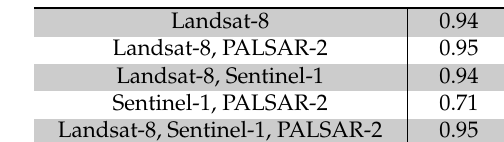
Table 4. Example mean withheld out-of-sample kappa values for Irrawaddy Delta combinations of imagery data and classifications.